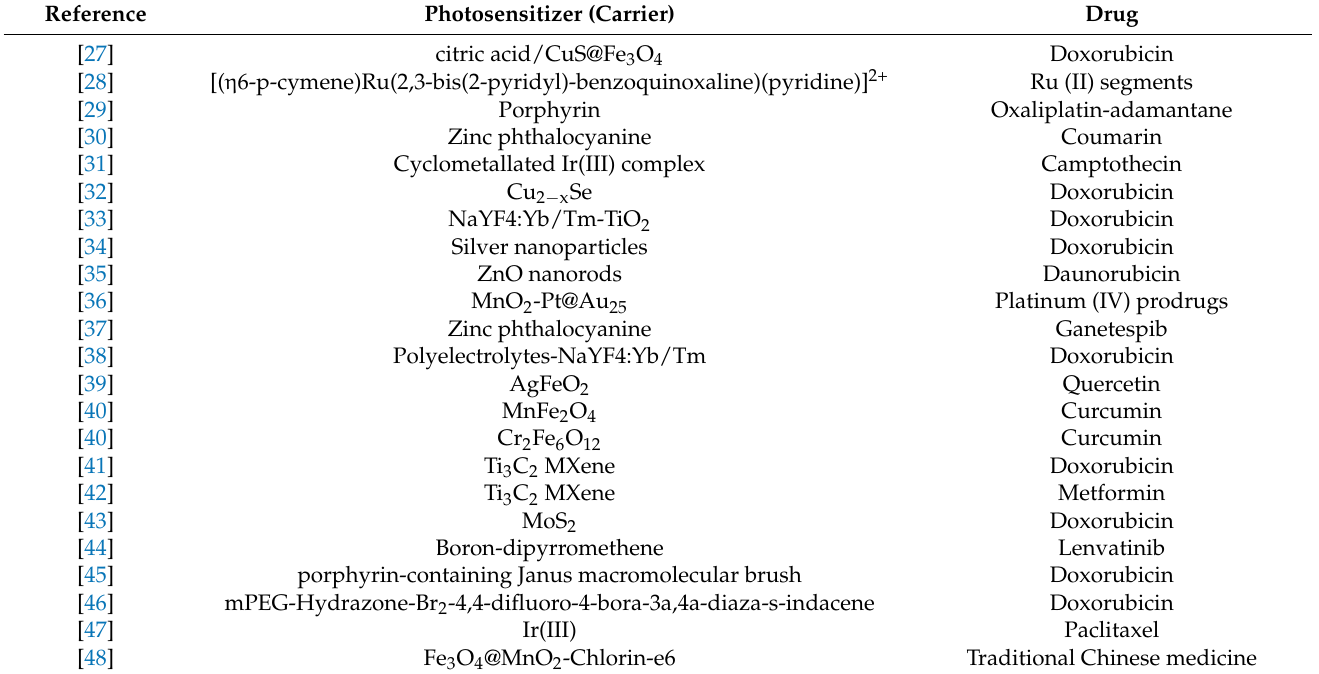
Table 2. Combination of photosensitizers and chemo-drugs without external